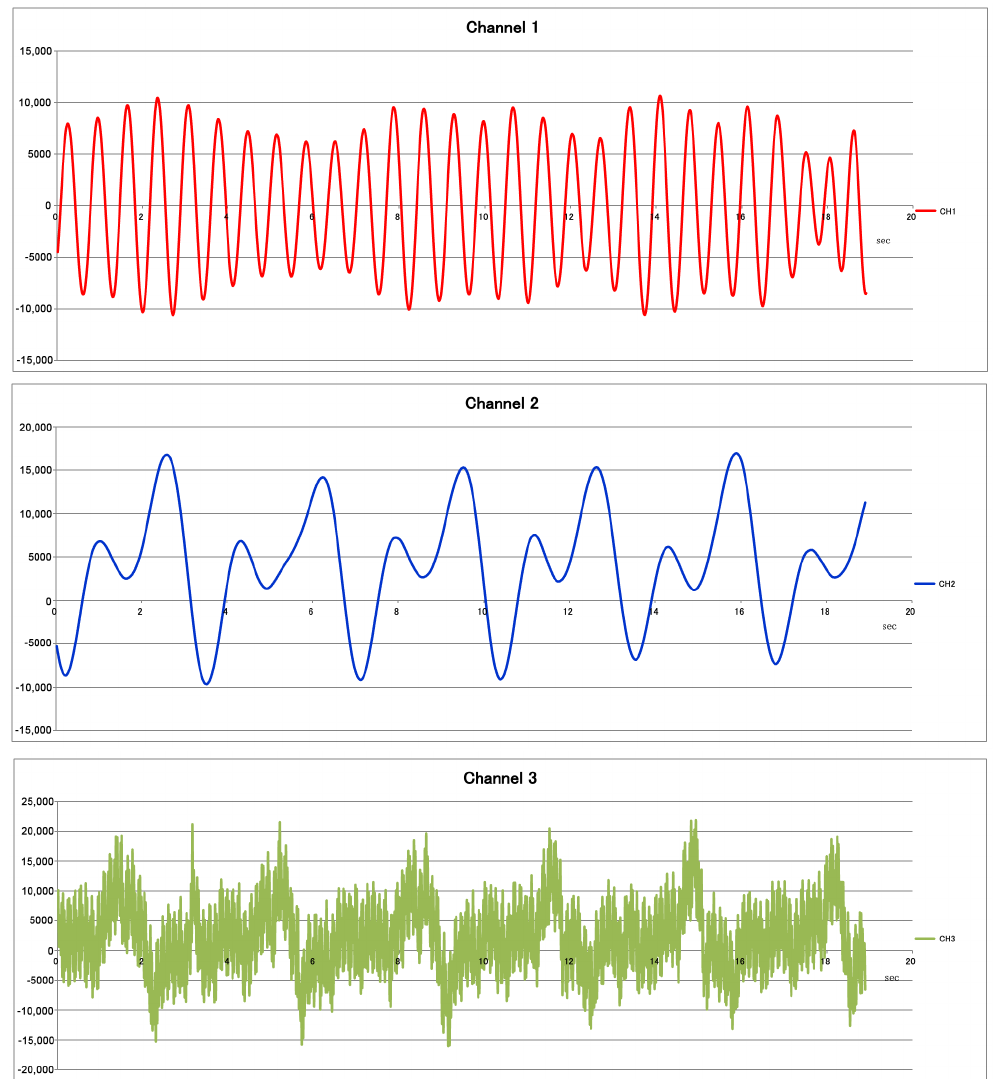
Figure 3. Channels of FWM7RAZ01 Doppler Radar Sensor.